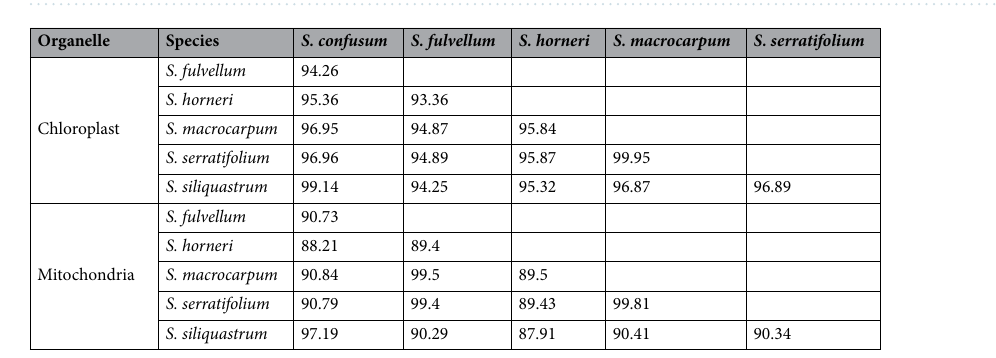
Table 3. Pairwise similarity (%) between organellar genome sequences of six Sargassum species.